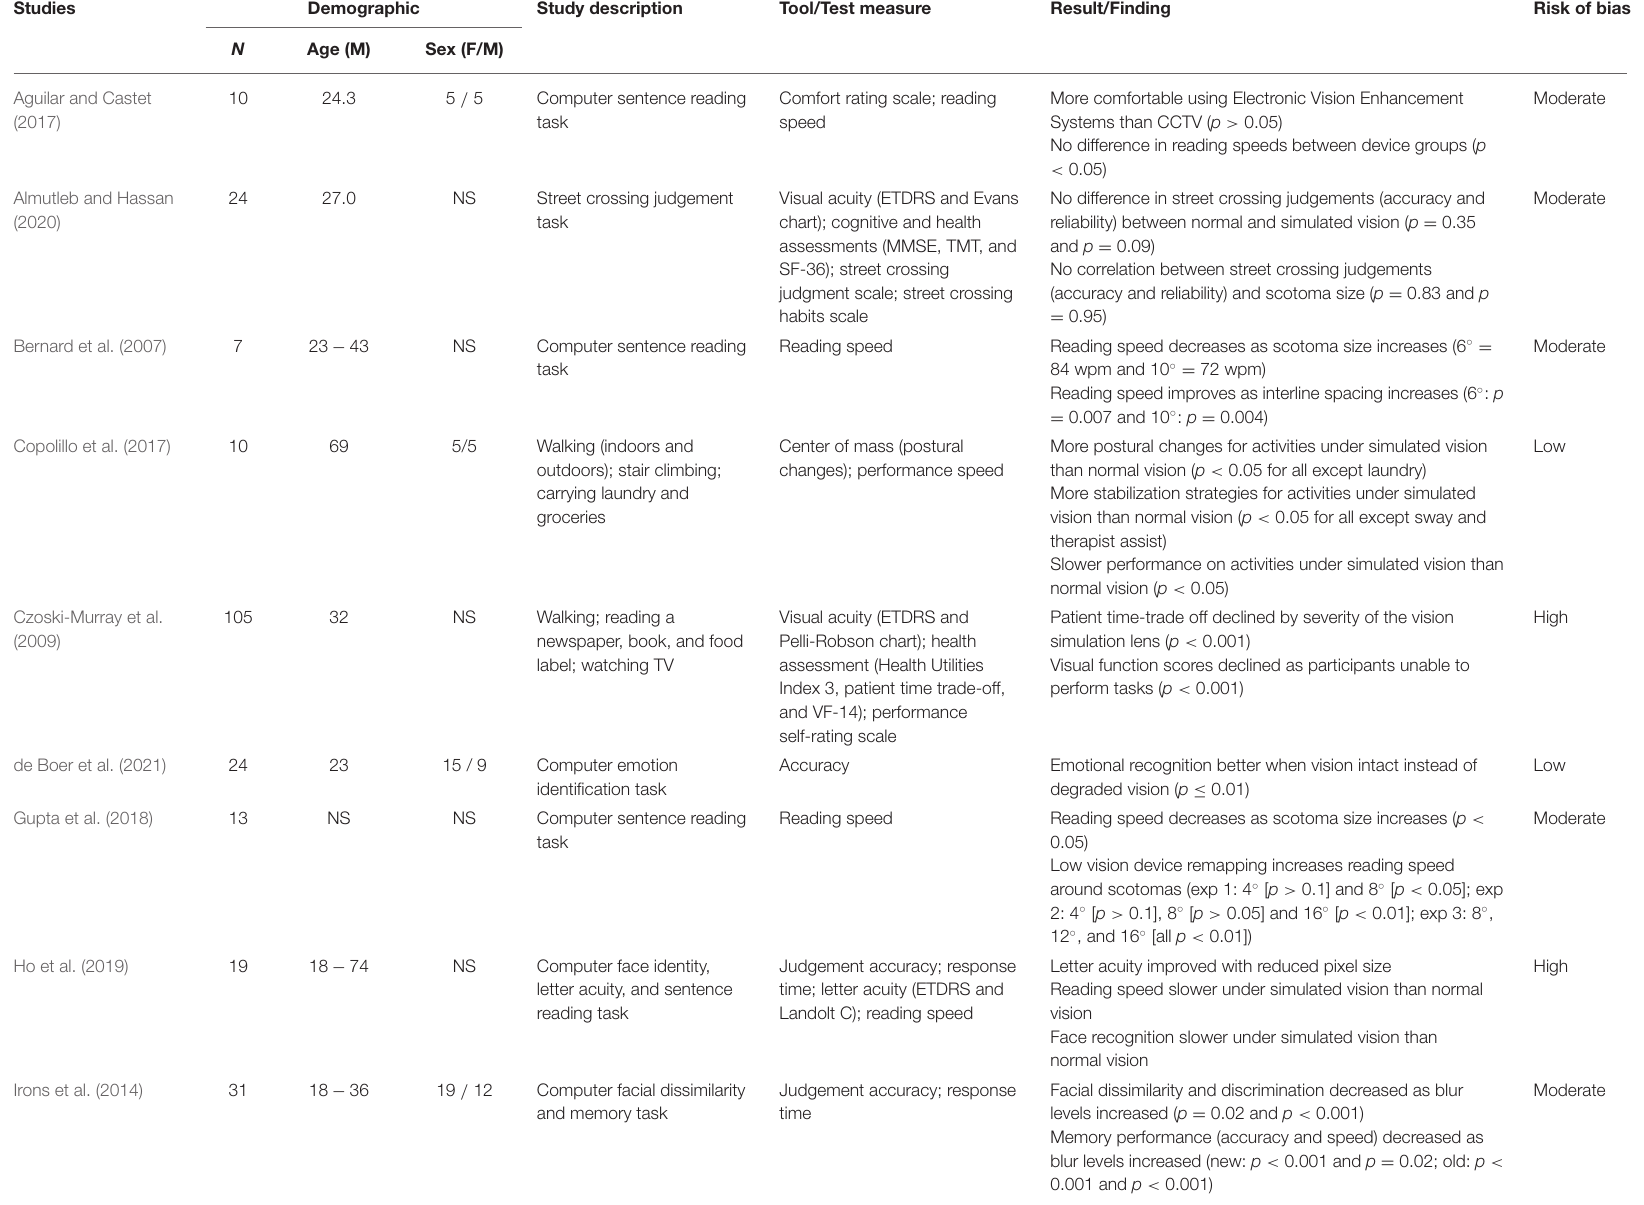
TABLE 1 | Age-related macular degeneration simulation